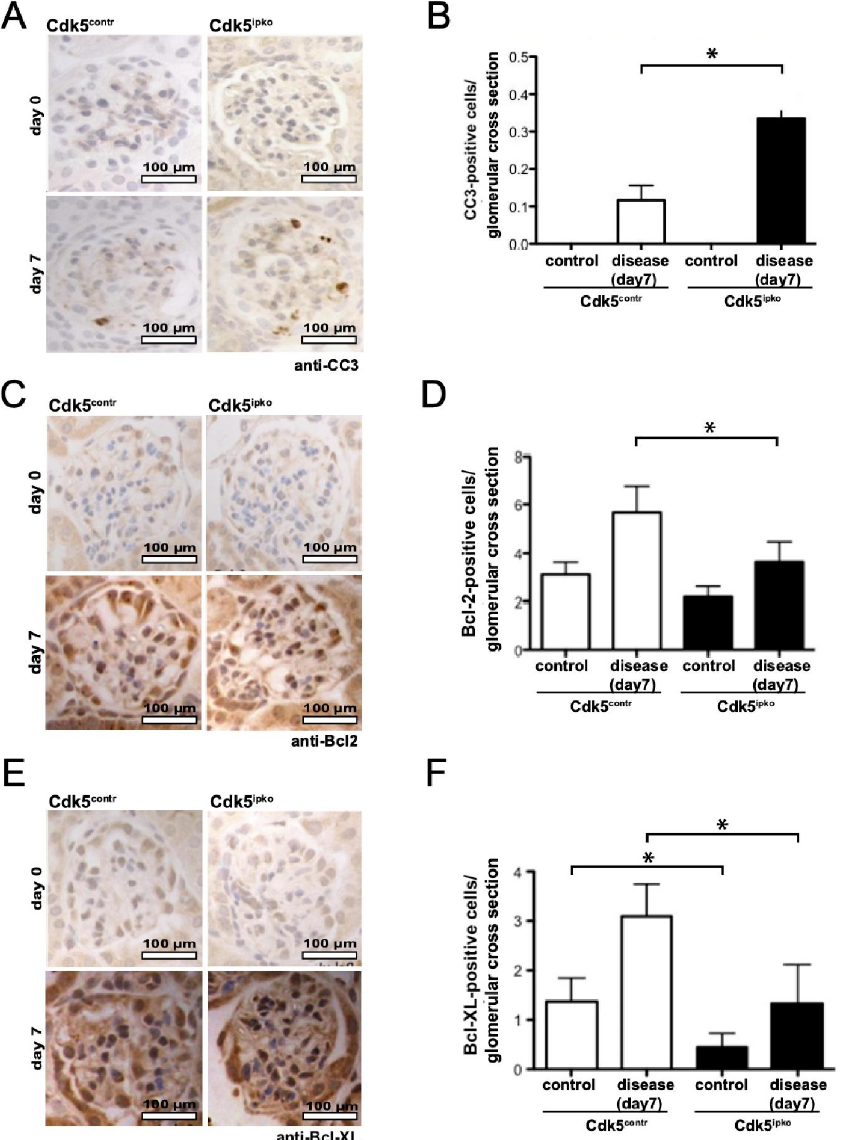
Figure 5. Analysis of pro- and anti-apoptotic signals dependent on podocyte expression of Cdk5 in the nephrotoxic nephritis model. ( A , B ): Detection of apoptotic cells by staining for cleaved caspase-3 (CC3) on kidney sections of Cdk5 contr and Cdk5 ipko mice. CC3-positive cells are more abundant in Cdk5 ipko as compared to Cdk5 contr (0.26 ± 0.05 vs. 0.12 ± 0.04; * p < 0.05). No CC3-positive cells were detected in mice treated with saline instead of NTS. In each cohort, n = 6. ( C , D ): Detection of anti-apoptotic Bcl-2 on kidney sections of Cdk5 contr and Cdk5 ipko mice. Increase in Bcl-2 expression after NTS challenge is lesser in Cdk5 ipko as compared to Cdk5 contr (3.7 ± 0.3 vs. 6.8 ± 0.5; * p < 0.05). Only few Bcl-2-positive cells were